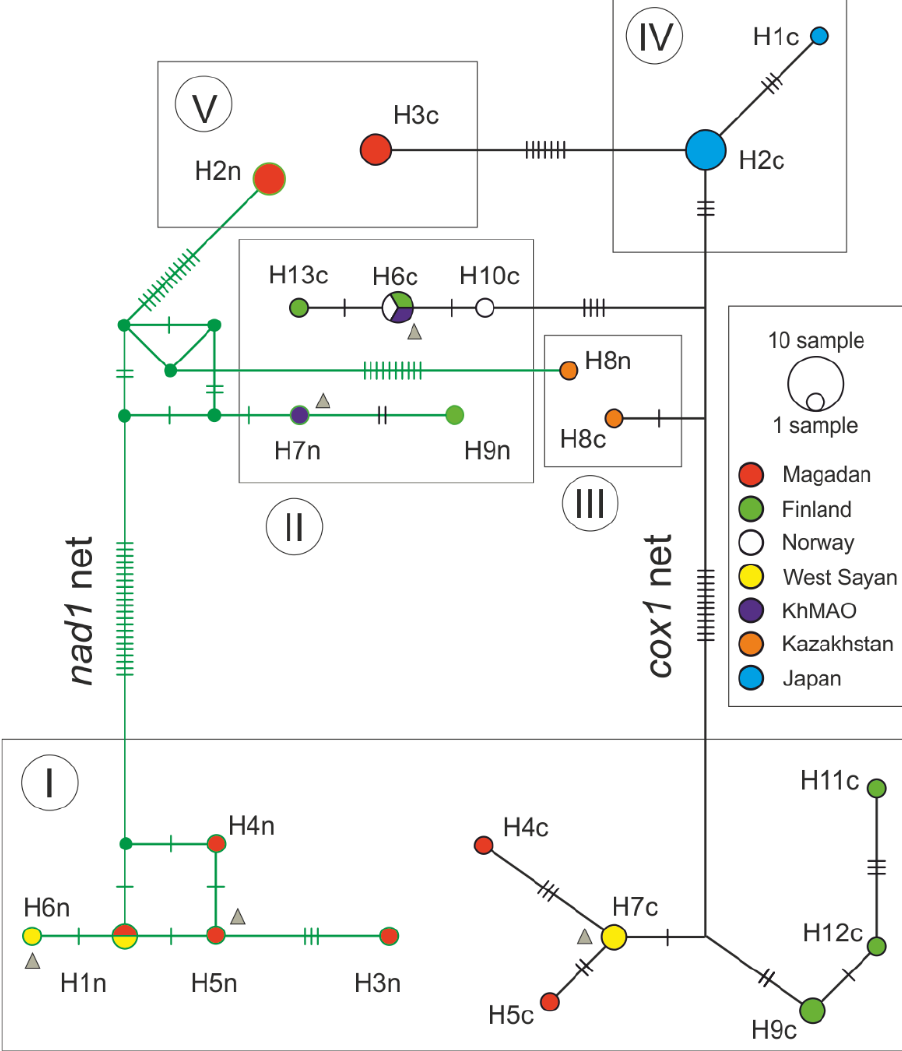
Figure 2. Median-joining network for Paranoplocephala kalelai constructed using the haplotypes of nad1 (green line) and cox1 (black line) fragment sequences. The size of the circles is proportional to the number of haplotypes. Dashes between haplotypes represent mutational steps between them. The color of the circle encodes the localities where the voles were captured. Haplogroup numbers are in Roman numerals. The triangle symbol next to the haplotype symbol indicates that the host is Myodes rutilus . In other cases, the host of the cestode is M. rufocanus .